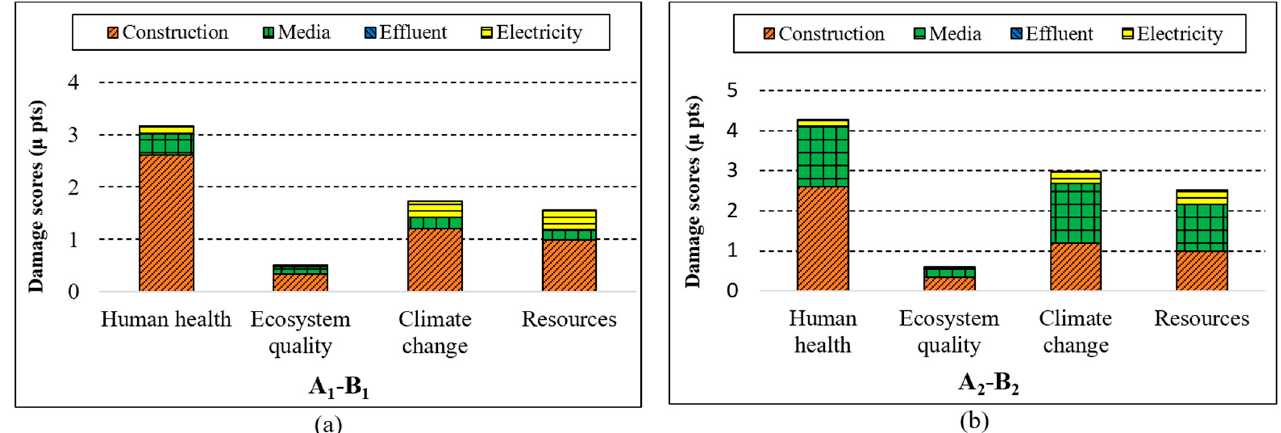
Figure 5. ( a , b ) . Life cycle impact assessment on four damage categories for ( a ) A 1 -B 1, and ( b ) A 2 -B 2, CW systems.